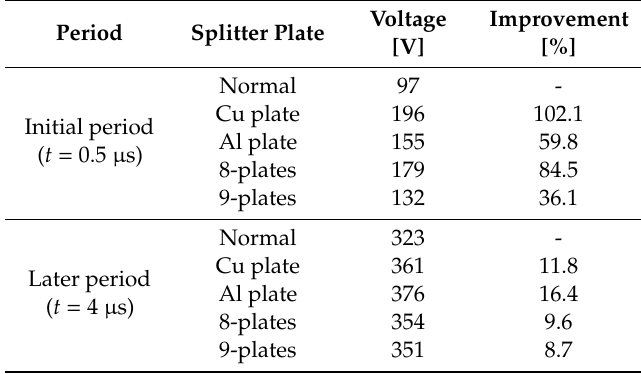
Table 4. Summary of DRV V–t